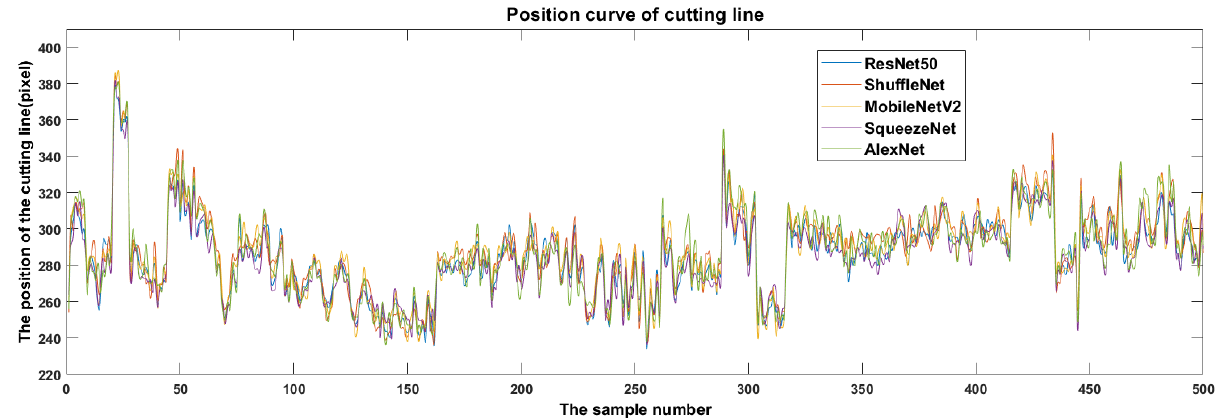
Figure 15. Cutting line location differences predicted by different backbone networks.